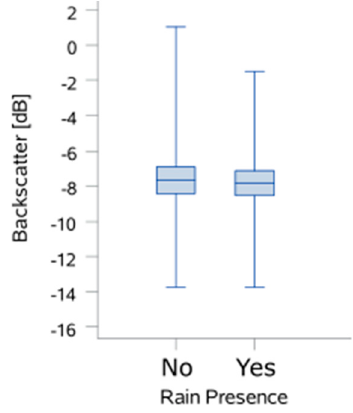
Figure 9. Comparison of backscatter during or not during a rain event. Note that there were only six images captured during a rain event. Table 2. Backscatter summary statistics .